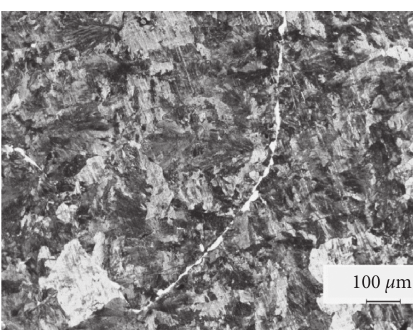
Figure 1: Initial microstructure of as-cast